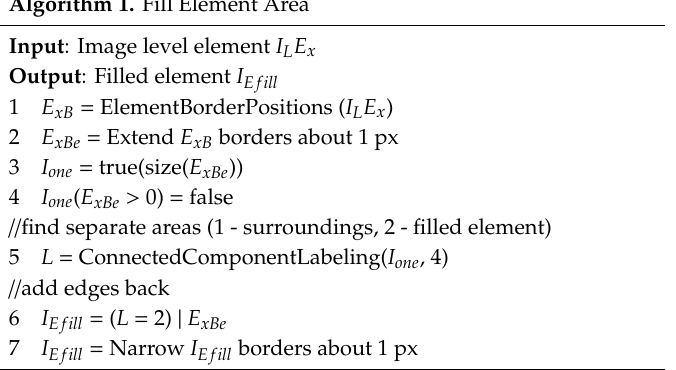
Algorithm 1. Fill Element Area